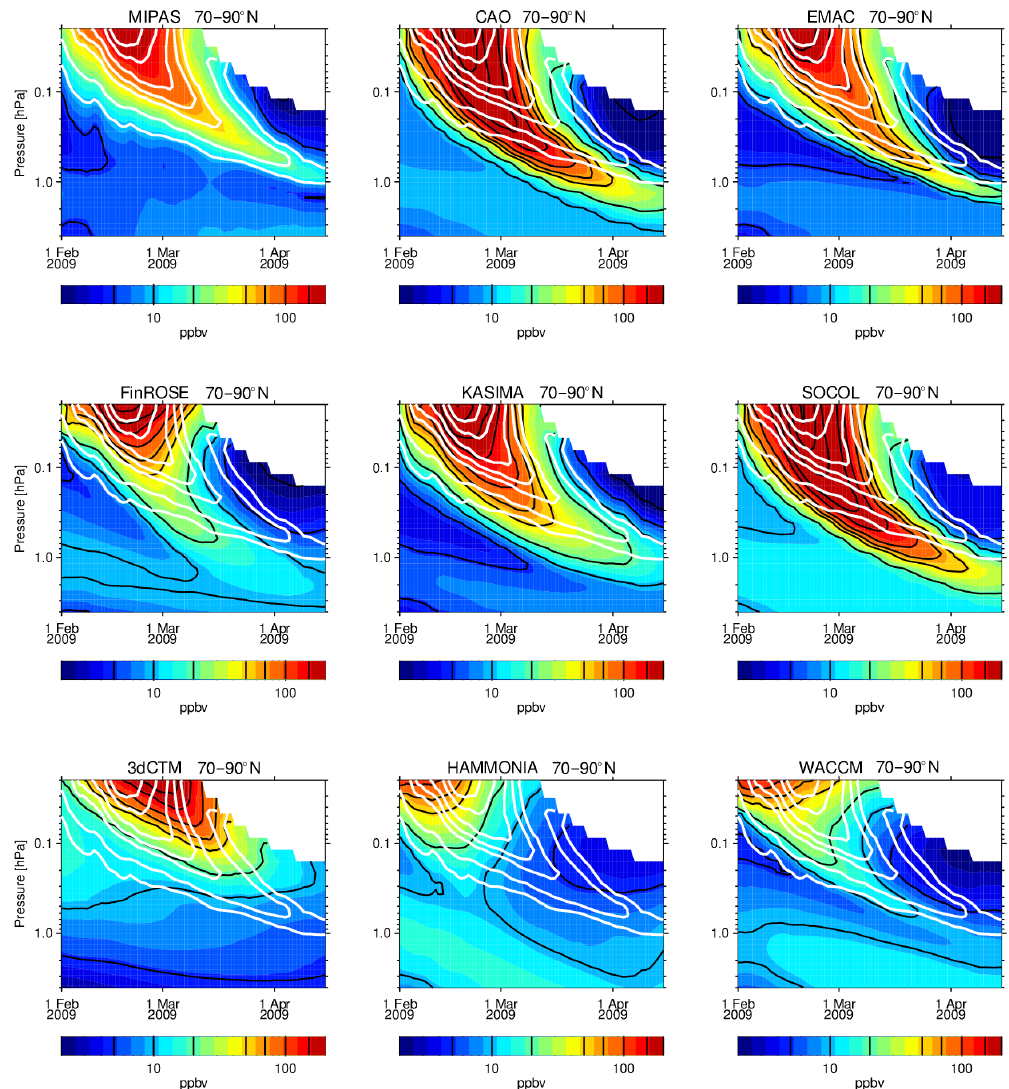
Figure 14. MIPAS-NOM and modelled temporal evolutions of NO x during the ES event at 1–0.02hPa within 70–90 ◦ N. White lines indicate the observed VMR levels of 10, 20, 50, 70, 100, 150, and 200ppbv.